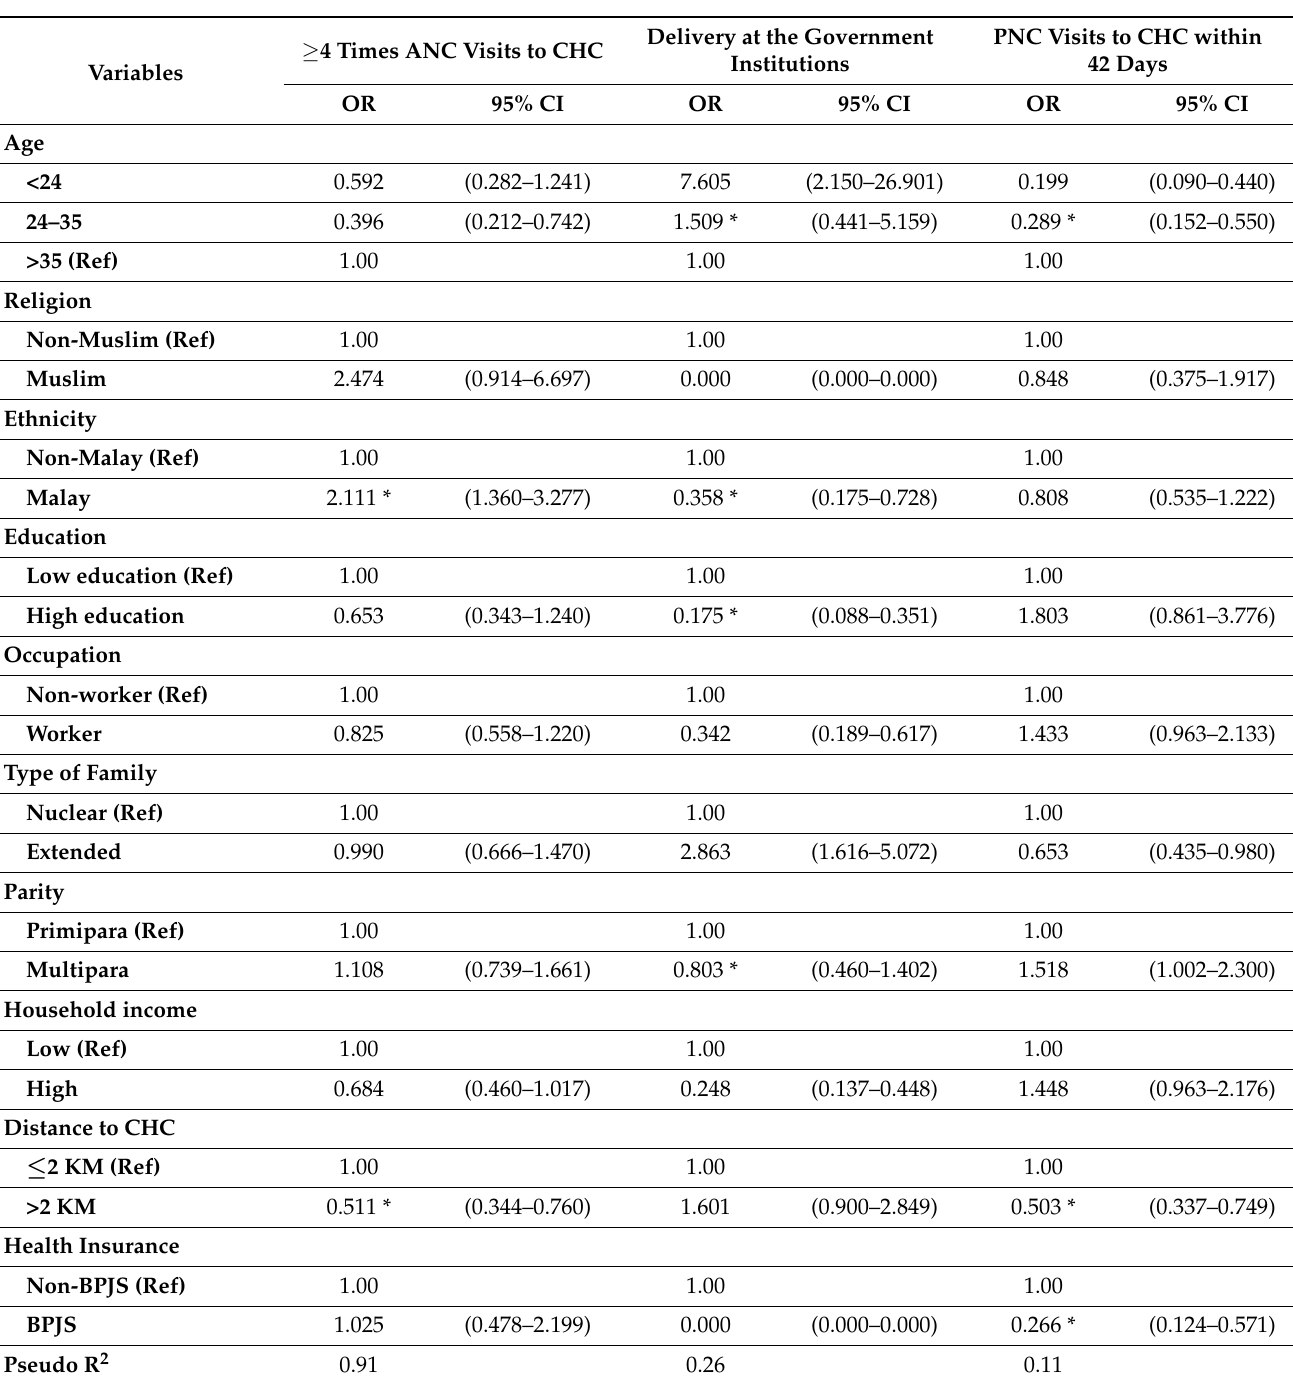
Table 4. Multivariate logistic regression for sociodemographic factors associated with the utilization of maternal health service at community health centers in Province of Jambi,